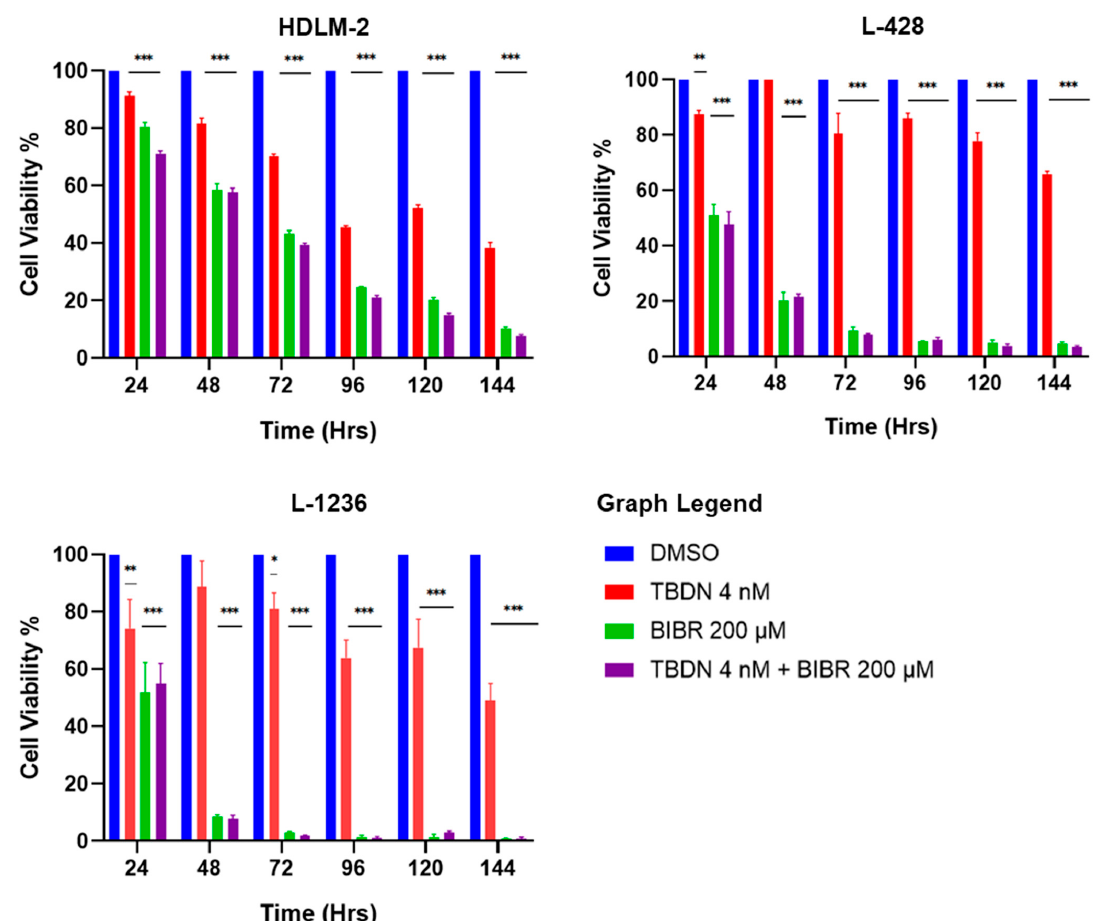
Figure 3. Combinatory inhibition of telomere maintenance pathways. HL cell lines show decrease in cellular viability upon treatment with trabectedin 4 nM (ALT pathway inhibitor). The effect was time-dependent in all HL cell lines. Incubation of HL cell lines with 200 µM BIBR 1532 (telomerase inhibitor) showed significant time-dependent decrease in cell viability. The combined inhibitory effect on both telomere maintenance pathways resulted in a remarkable time-dependent decrease in cellular viability, in all HL cell lines. Data expressed as mean ± SEM. * p < 0.05, ** p < 0.001 and *** p < 0.0001. TBDN—trabectedin.